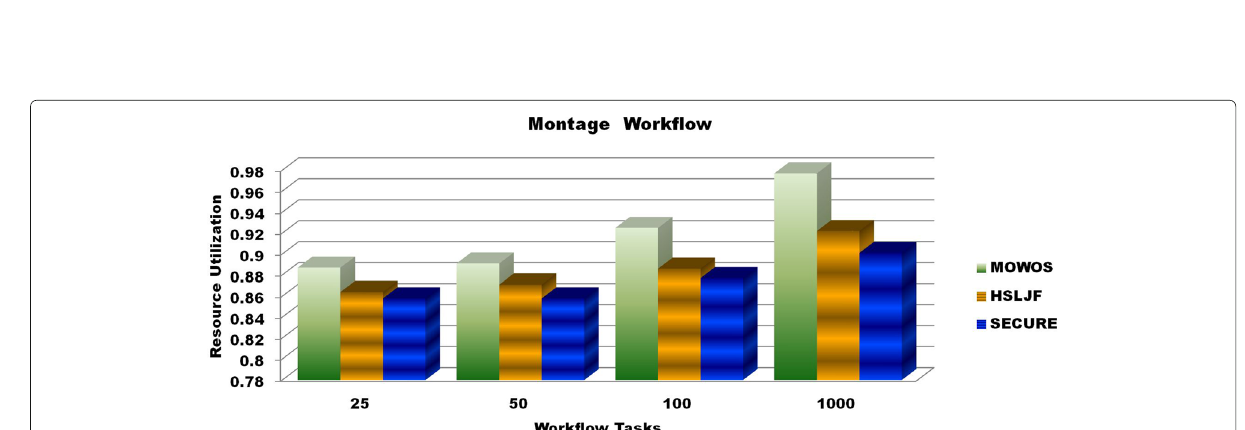
Fig. 13 Comparison of resource utilization using Montage